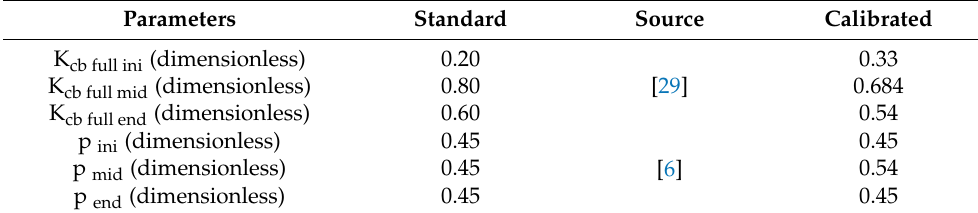
Table 3. Standard and calibrated model parameters.